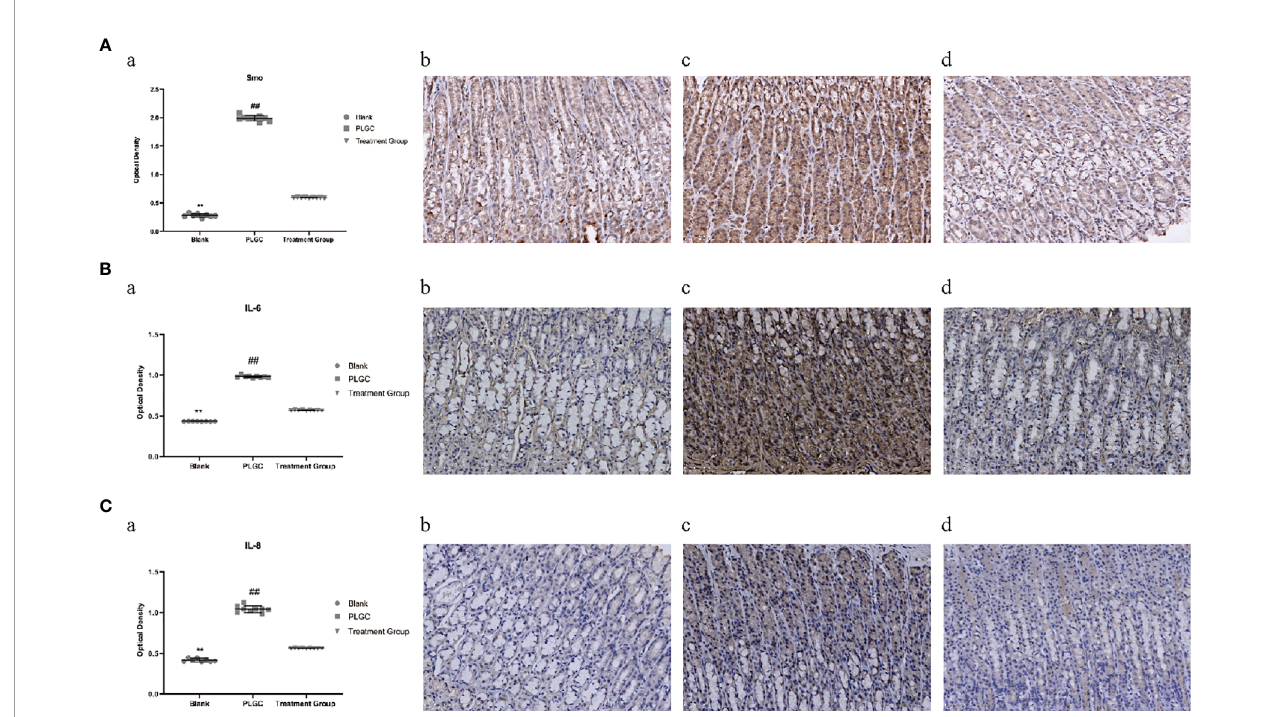
FIGURE 7 | Comparison of expression levels of Smo, IL-6, and IL-8 protein in the gastric tissue of rats in different groups. (A) The expression of Smo in the gastric tissue of rats was detected by immunohistochemistry. (B) The expression of IL-6 in the gastric tissue of rats was detected by immunohistochemistry. (C) The expression of IL-8 in the gastric tissue of rats was detected by immunohistochemistry. ** P < 0.01 vs. Blank; ## P < 0.01 vs. PLGC. Scale bar: 50